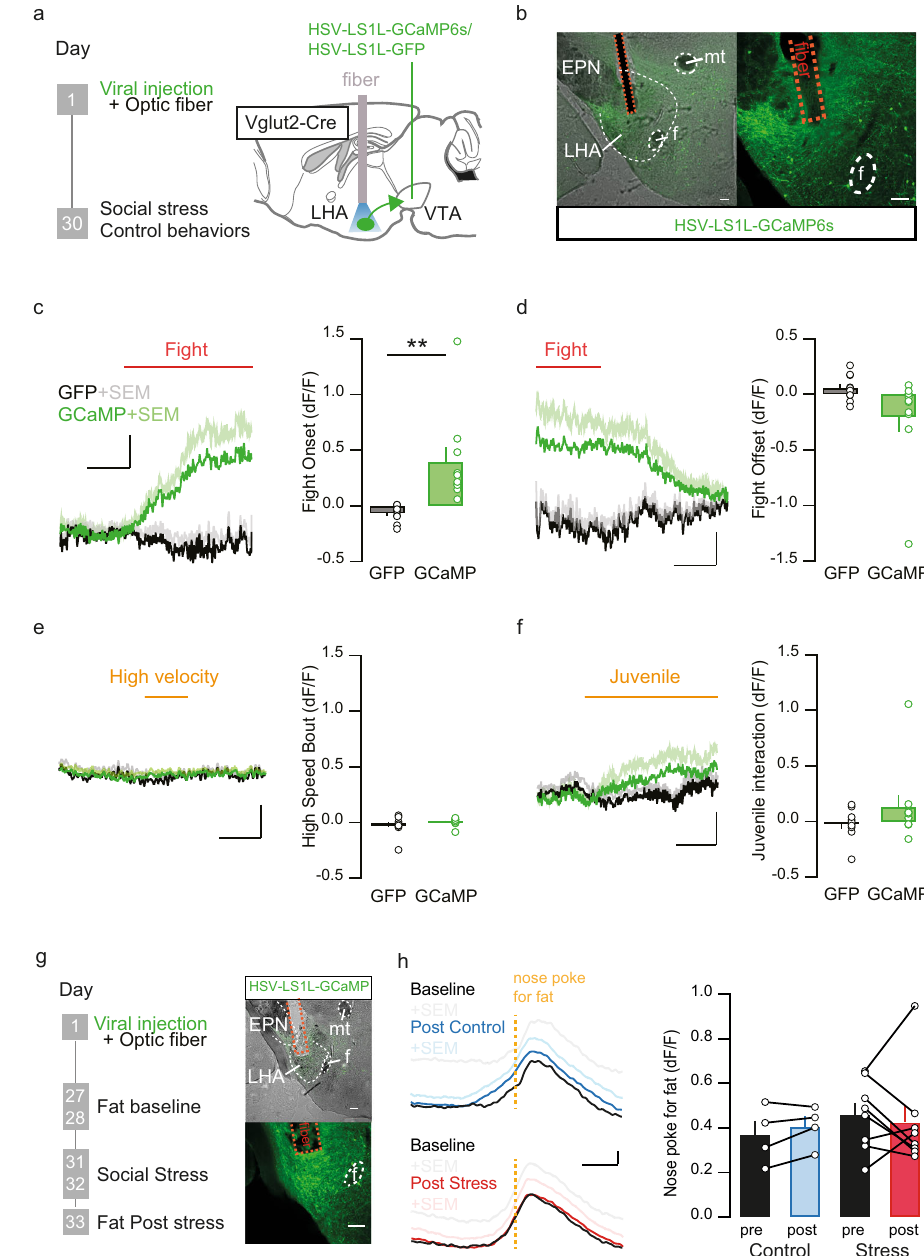
Fig. 2 | LHA glutamatergic neurons projecting to VTA are stress sensitive. a Timeline and schematic for Fiber photometry experiments during stress. b Representative image of viral expression of GCaMP6s in LHA glu neurons pro- jectingtotheVTA(ingreen),withanoptic fi berabovetheLHA(scalebars:100 µ m). Anatomical reference points: f fornix, EPN entopeduncular nucleus, mt mammil- lothalamic tract. c Average recorded emitted fl uorescent signal of GCaMP6s with SEM (dF/F) (green; n =10) and control GFP (black; n =10) of LHA glu neurons pro- jecting to VTA,time-lockedto fi ghts(red line).Scale bars:2s, 0.25dF/F.Quanti fi ed peak signals compared to baseline during fi ght onset of GCaMP and GFP control groupswithSEM(micepergroup n =10,One-WayANOVAF (1,18) =12.03, p =0.003). d As ( c ), but for fi ght offset (end of the red line) (mice per group n =10, One-Way SEM of GCaMP6s signal and GFP (dF/F) of LHA glu -VTA neurons time-locked to the onset of high velocity bouts. Scale bars: 1s, 0.25 dF/F. Quanti fi ed peak signals compared to baseline during high velocity bouts for GCaMP and GFP control groups. Error bars indicate SEMs (mice per group n =9, One-Way ANOVA,